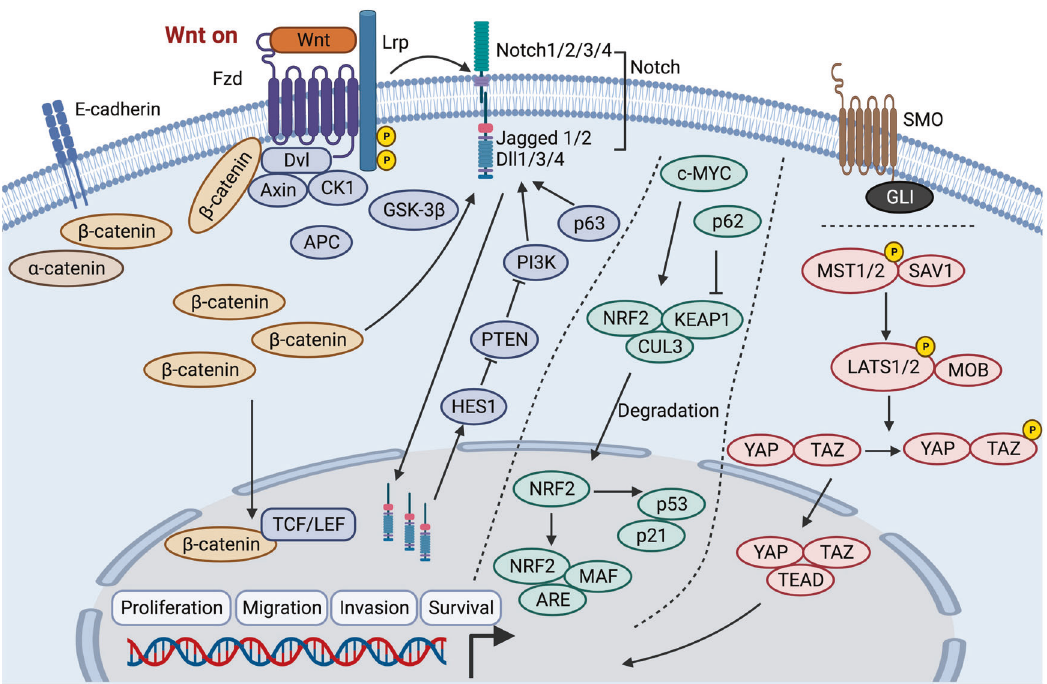
Fig. 4 Wnt/ β -catenin signaling pathway, Notch pathway, NRF2 pathway, Hippo pathway, and Sonic Hedgehog pathway in head and neck cancer. Fzd frizzled receptor, Lrp receptor-related protein coreceptor, Dvl disheveled, CK1 casein kinase 1, GSK-3 β glycogen synthase kinase 3 β , APC adenomatous polyposis coli, TCF/LEF T-cell factor/lymphoid enhancing factor, Dll 1/3/4 Delta-like family, HES1 hairy and enhancer of split 1, NRF2, nuclear factor erythroid 2-related factor 2, KEAP1 Kelch-like ECH-associated protein 1, CUL3 cullin-3, ARE antioxidant-responsive elements, YAP yes-associated protein, TAZ transcriptional coactivator with PDZ-binding